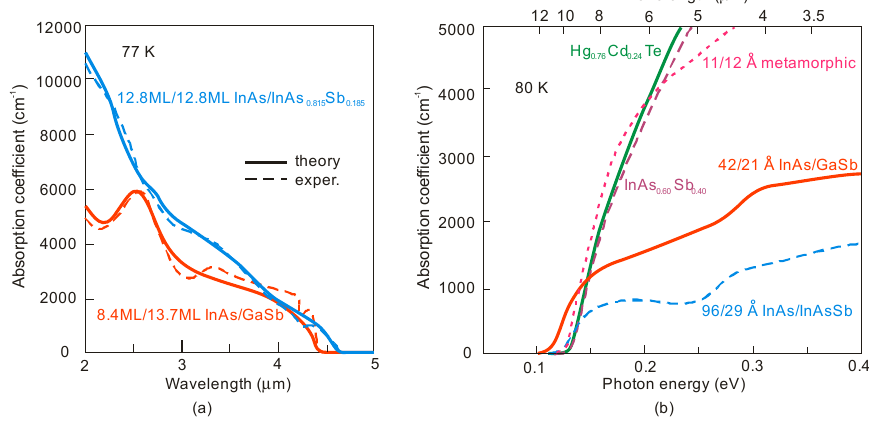
Figure 27. Experimental and theoretical absorption spectra for MWIR InAs/GaSb and InAs/InAsSb T2SLs at 77 K ( a ) (adapted after [110]) and LWIR HgCdTe and different III-V material systems at 80 T2SLs at 77 K ( a ) (adapted after [110]) and LWIR HgCdTe and di ff erent III-V material systems at 80 K K ( b ). ( b ) presents only calculated interband absorption coefficients for bulk InAs 0.60 Sb 0.4 , ( b ). ( b ) presents only calculated interband absorption coe ffi cients for bulk InAs 0.60 Sb 0.4 , Hg 0.76 Cd 0.24 Te, Hg 0.76 Cd 0.24 Te, and T2SLs: 42Å InAs/21Å GaSb, 96Å InAs/29Å InAs 0.61 Sb 0.39 and 11Å InAs 0.66 Sb 0.34 /12Å and InAs 0.36 Sb 0.64 metamorphic.